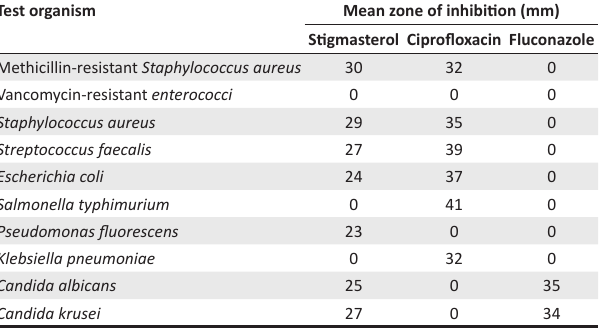
TABLE 1: Susceptibility of stigmasterol to various test organisms. Test organism Mean zone of inhibition (mm)